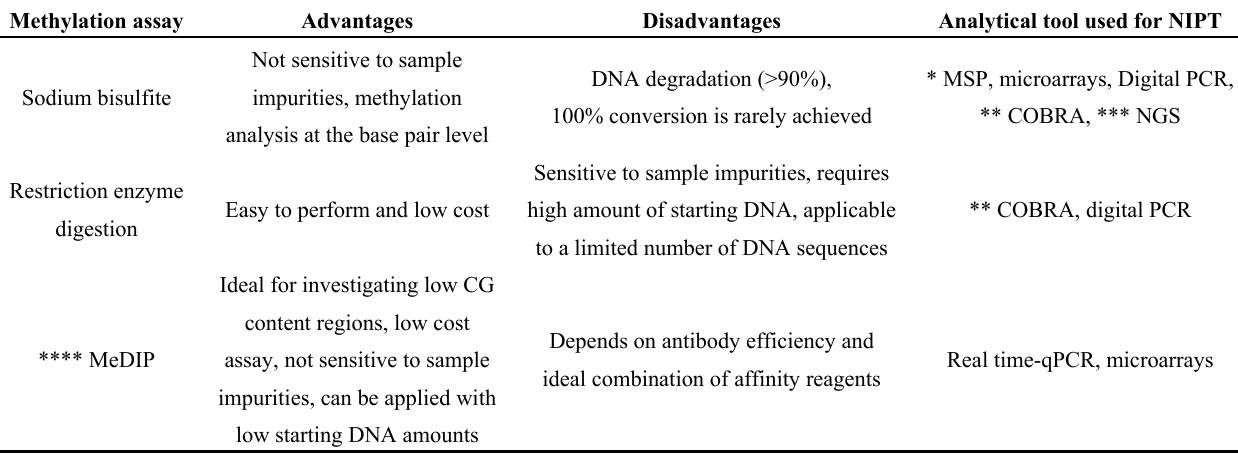
Table 2. Comparison of different methylation